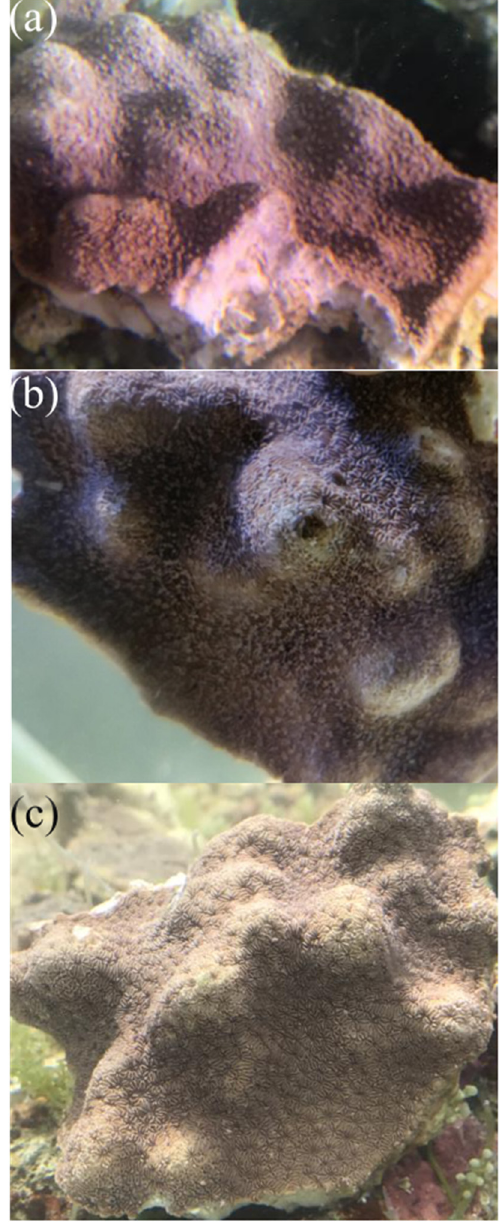
Figure 1. Changes in the phenotypes of corals under different temperature stresses. ( a ) 18 °C, LT; ( b ) 26 °C, CK; and ( c ) 34 °C, HT.